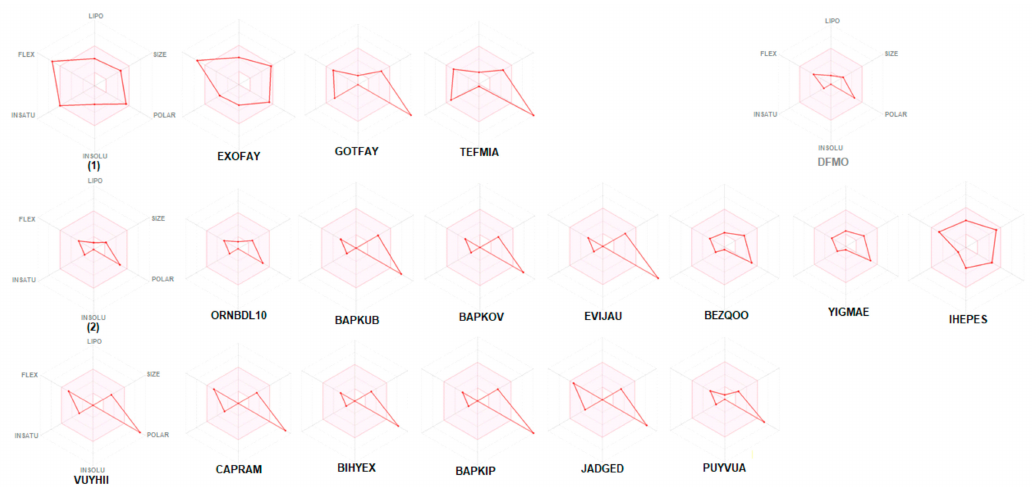
Figure 11. Bioavailability radar (pink area exhibits optimal range of particular property) for studied compounds [LIPO = lipophilicity as XLOGP3; SIZE = size as molecular weight; POLAR = polarity as TPSA (topological polar surface area); INSOLU = insolubility in water by log S scale; INSATU = insaturation as per fraction of carbons in the sp 3 hybridization and FLEX = flexibility as per rotatable